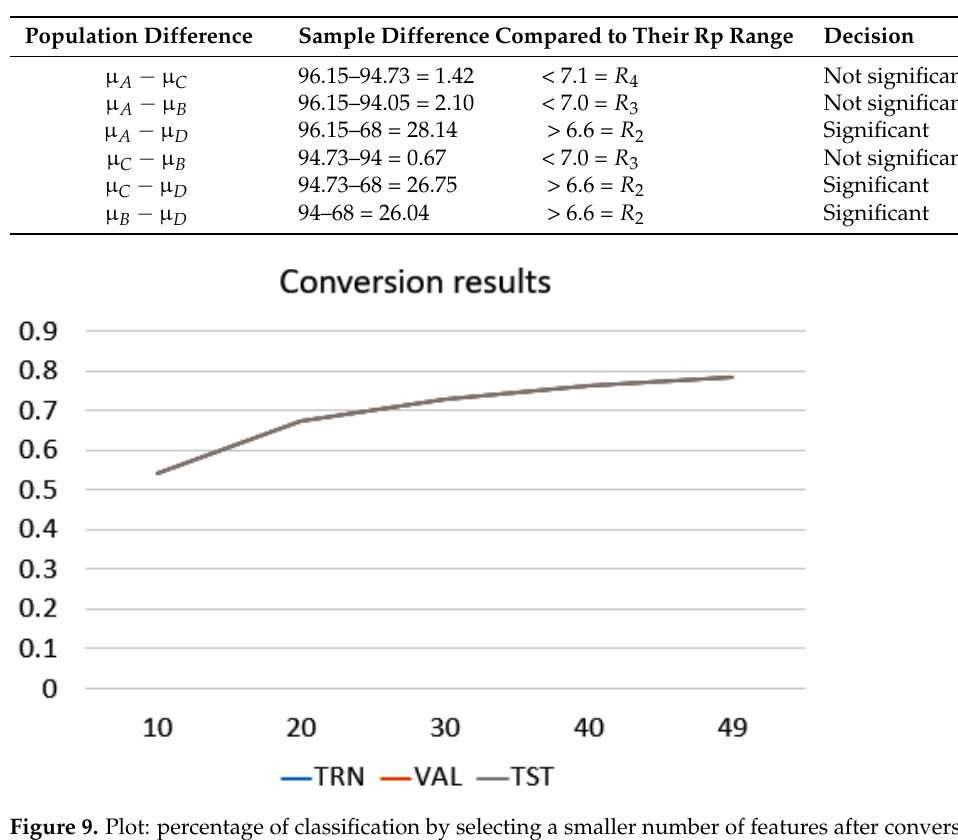
Table 10. Table for results of Duncan’s significance testing; the conclusion is that the means of the results obtained from the procedures A, B and C are equal, and D (without any processing) is not equal. Therefore, any of the treatments “normalization and SFS”, “only normalization” and “only with SFS” can be chosen.